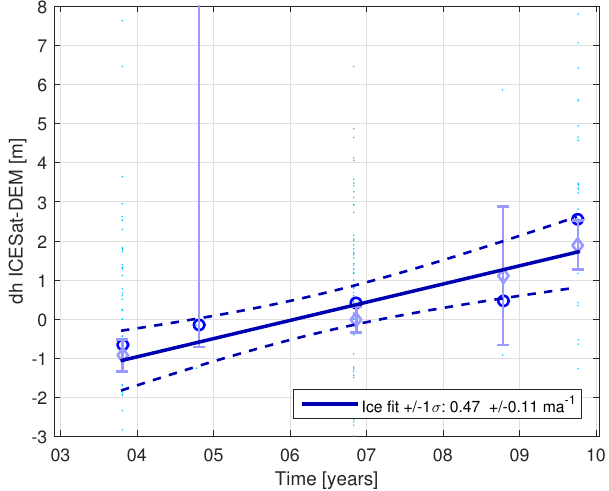
Figure 7. The autumn 2003–2009 trend for samples only on those glaciers that are covered by the autumn 2009 campaign (Myklebust- breen and Haugabreen) is strongly positive. The large error bars in 2004 and 2008 result from the very low campaign sample numbers of only three and seven samples